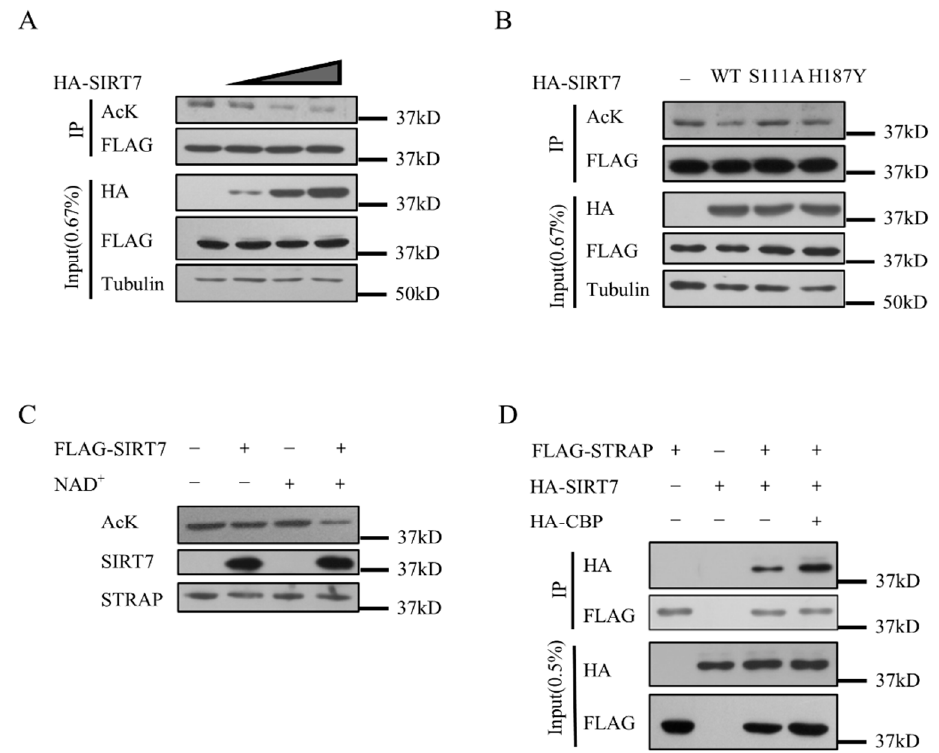
Figure 3. Sirt7 deacetylates STRAP in vivo and in vitro. ( A ) In vivo deacetylation assay for STRAP. HEK293T cells were co-transfected with Flag-STRAP, HA-CBP, or with increasing amounts of HA-SIRT7 plasmid, followed by deacetylation assays. ( B ) HEK293T cells were co-transfected with Flag-STRAP, HA-CBP and empty vector or with HA-SIRT7 (WT), HA-SIRT7-S111A (S111A) or HA-SIRT7-H187Y (H187Y), followed by deacetylation assays. ( C ) In vitro deacetylation assay for STRAP. High acetylated Flag-STRAP and HA-SIRT7 were purified from HEK293T cells, followed by in vitro deacetylation assays, in the presence of NAD + or not. ( D ) CBP can enhance the interaction of SIRT7 and STRAP. Western blotting of whole-cell extracts and co-immunoprecipitates with the anti-Flag M2 beads from cells transfected with or without Flag-STRAP / HA-SIRT7 / HA-CBP as